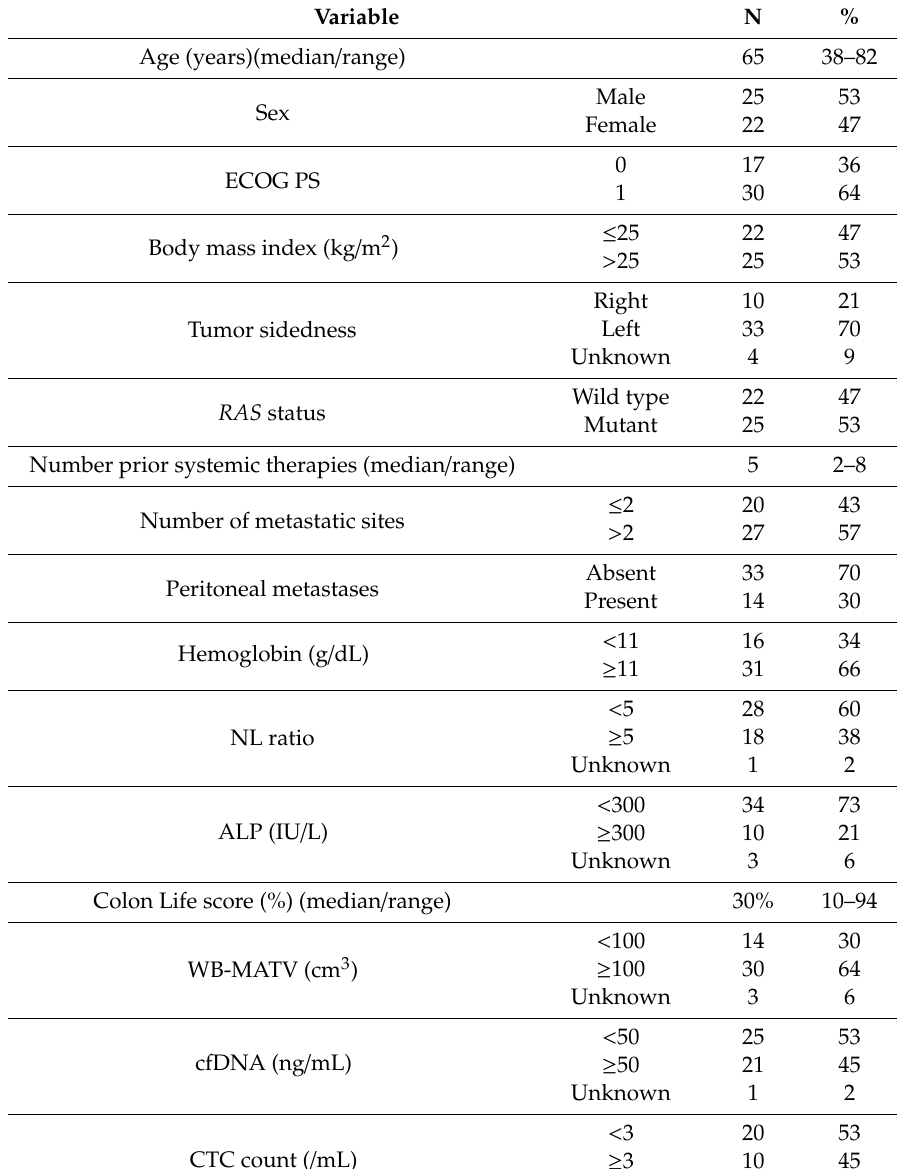
Table 1. Baseline patient